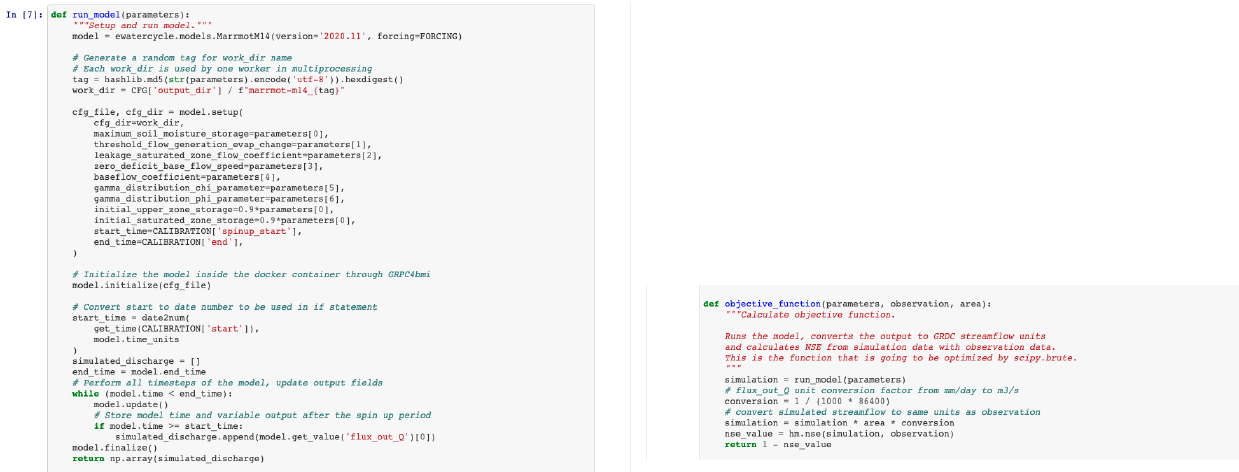
Figure 14. A snippet of the code used to run the calibration experiment described in Sect. 4.5. The entire workflow of the first use case presented in Sect. 4.1 is wrapped into the function run_model() (left part of the figure). This function runs the model for a given set of parameters. This function is called in objective_function(), which is passed as an argument to the calibration scheme of the CMA-ES/pycma package. This package, based on settings provided, runs multiple instances of the objective_function() (and thus of the hydrological model) in parallel to find the optimum set of parameters that optimize the objective function.